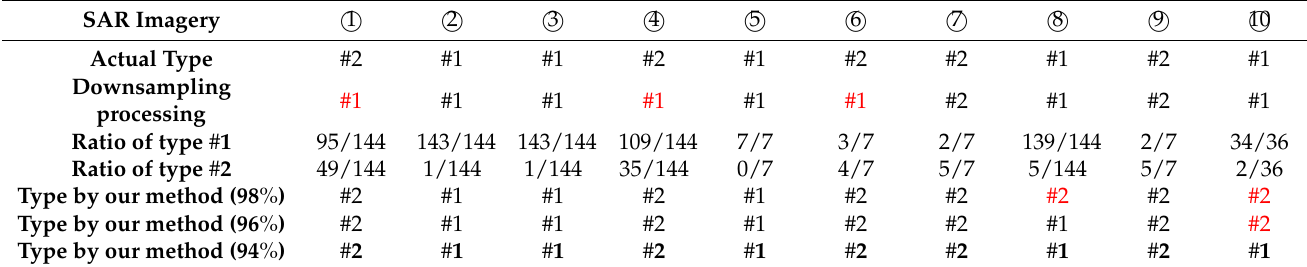
Table 3. Classification results of ten large imageries based on VGGNet16. The wrong classification are marked in red. SAR Imagery